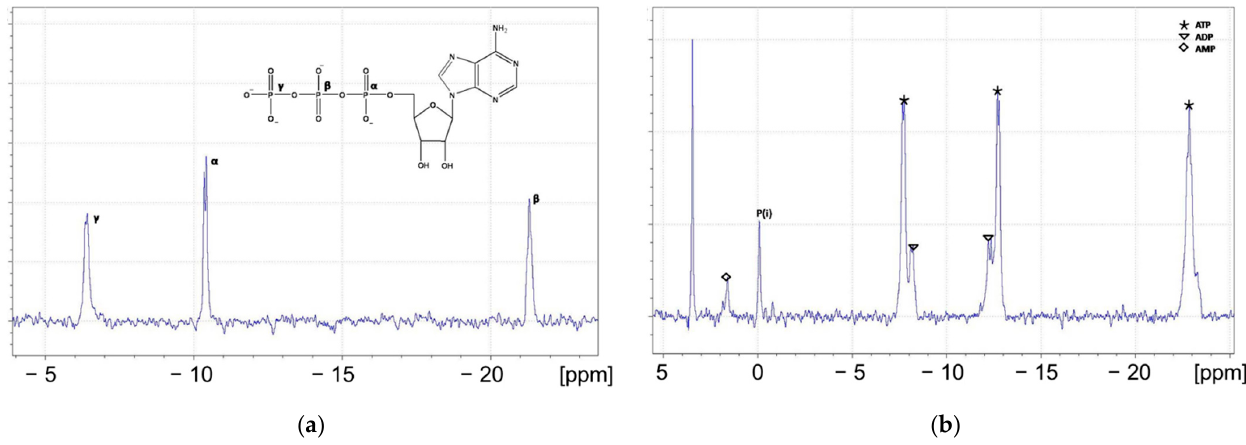
Figure 1. ( a ) 31 P ‐ NMR spectrum of ATP (20 mM in H 2 O/D 2 O at pH 7.0). The phosphate resonances are assigned as shown in the structure of ATP. ( b ) Representative 31 P ‐ NMR spectra obtained during the course of the hydrolytic reaction between ATP and vanadate (pH 6.0, 25 °C, 4 days). Small shift in the resonances of ATP and reaction products are attributed to slight variations in solution acidity given the absence of buffer in the reaction mixture.